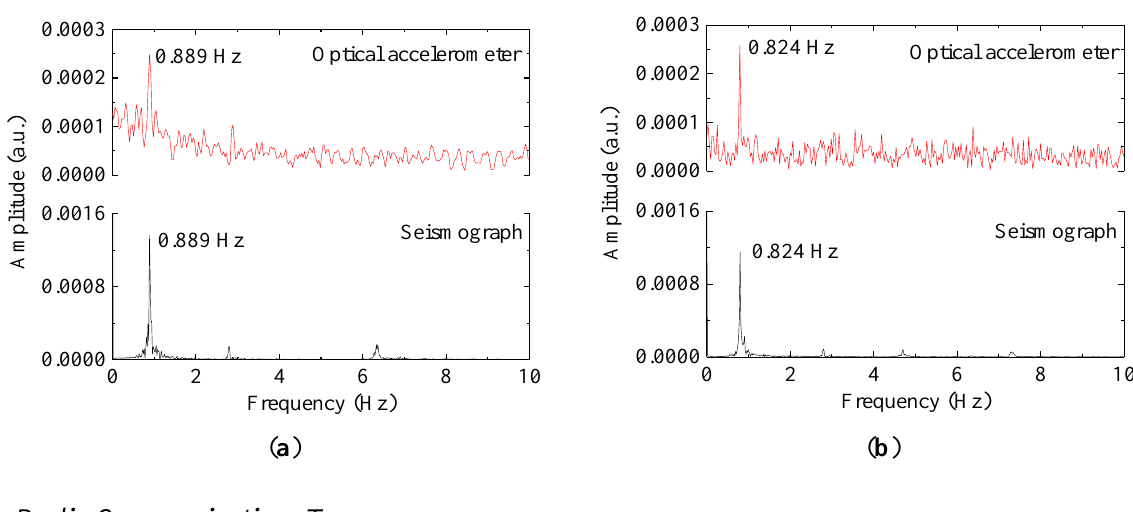
Figure 7. Frequency acceleration spectra from the data recorded in the transversal direction ( a ) and in the longitudinal direction ( b ).